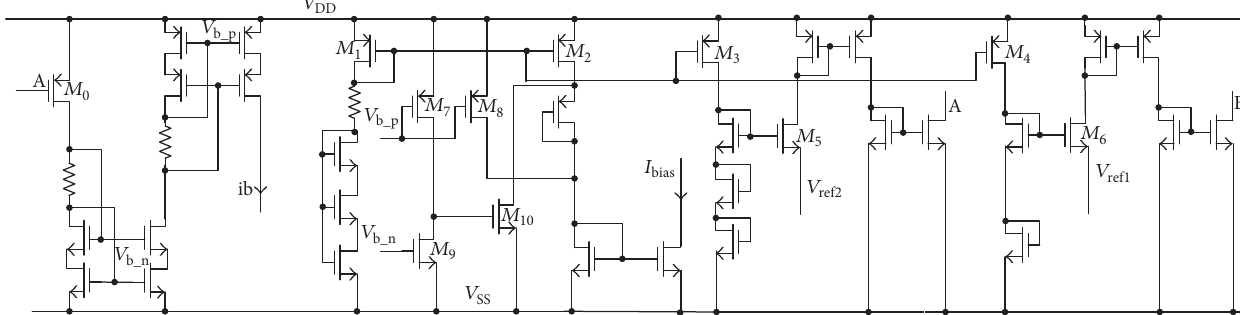
Figure 5: Start-Up circuit with self-bias current